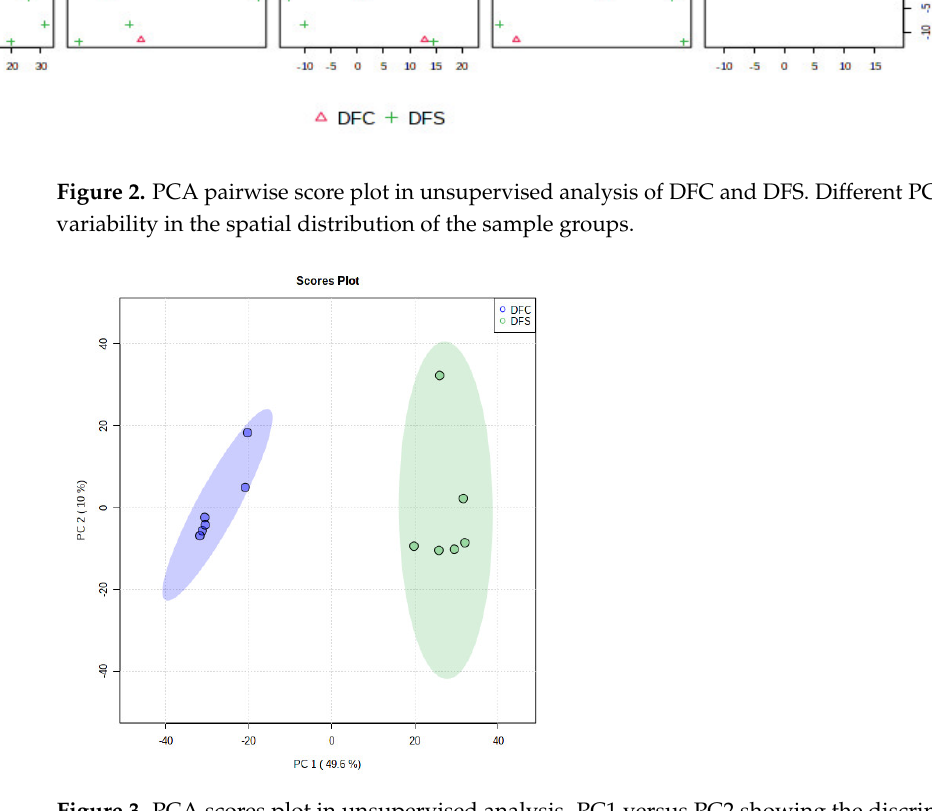
Figure 3. PCA scores plot in unsupervised analysis. PC1 versus PC2 showing the discrimination of DFC and DFS growing in different culture media.